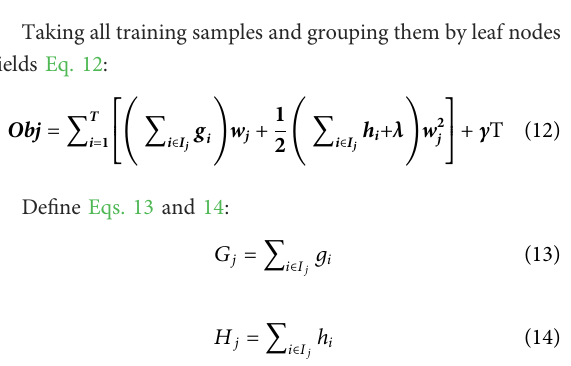
Algorithm 1. stacking